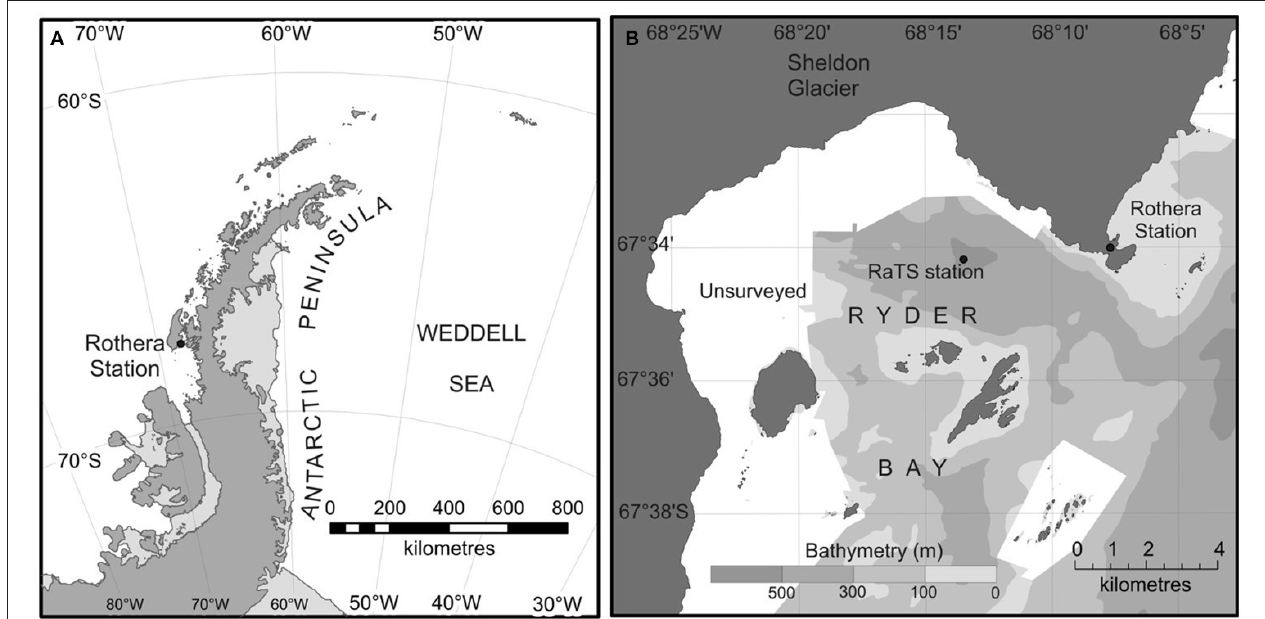
FIGURE 1 | (A) : map of the western Antarctic Peninsula, marked with the location of Rothera Research Station on Adelaide Island in northern Marguerite Bay. (B) : An expanded view of the immediate vicinity of Rothera, including Ryder Bay where the RaTS long-term monitoring station is situated.